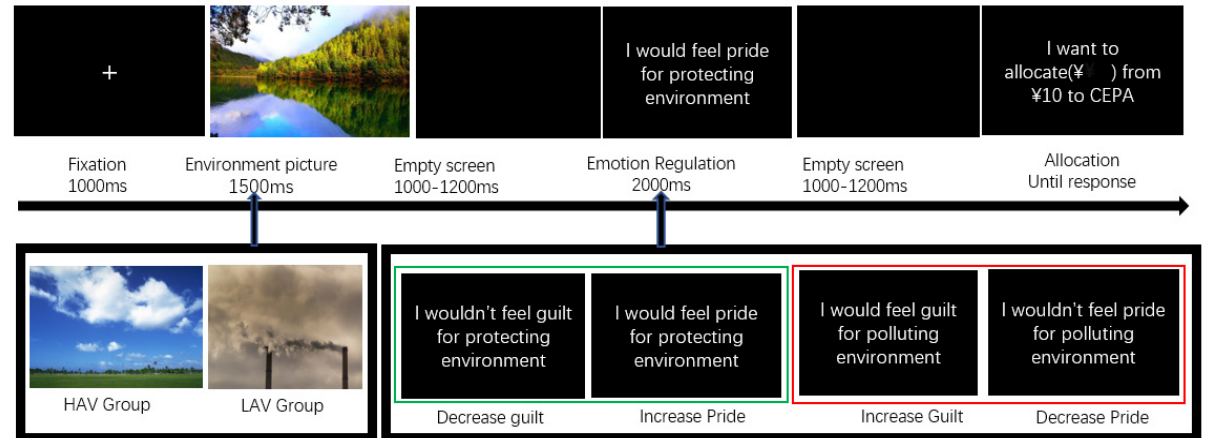
Figure 1. Trail structure of the experiment. Content in green boxes indicate that positive environmental framing increases anticipated pride and reduces anticipated guilt, while red boxes indicate that negative environmental framing increases anticipated guilt and reduces anticipated pride.